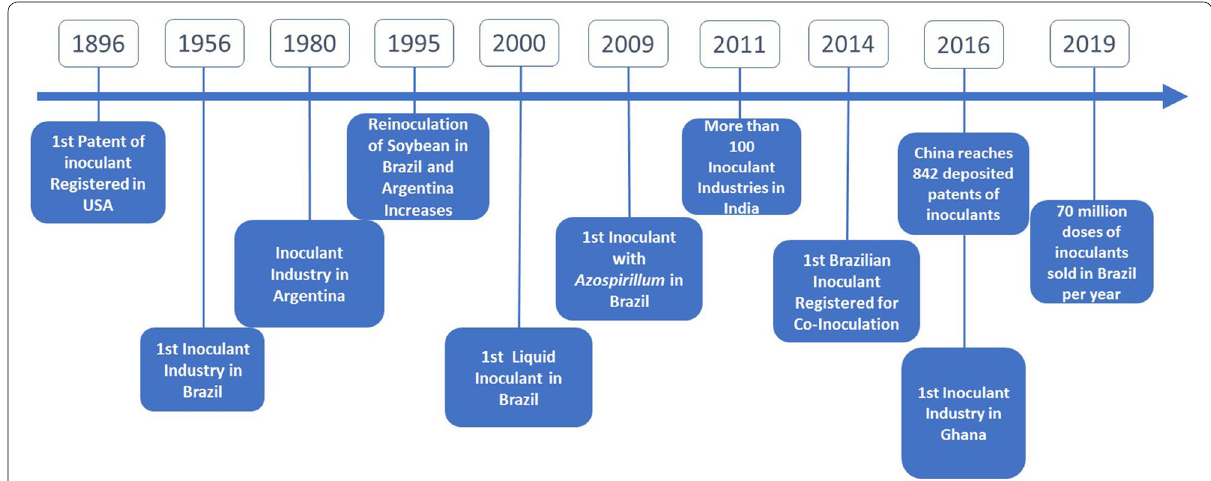
Fig. 2 Chronology of some important steps in the development of microbial